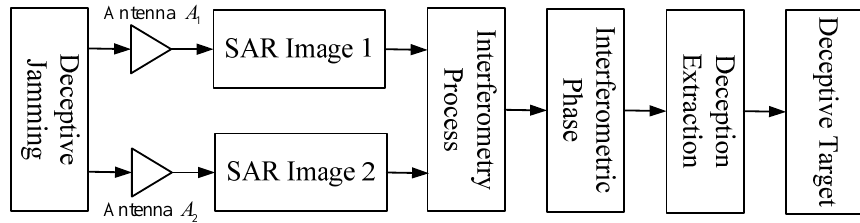
Figure 3. Flowchart of the proposed detection scheme.